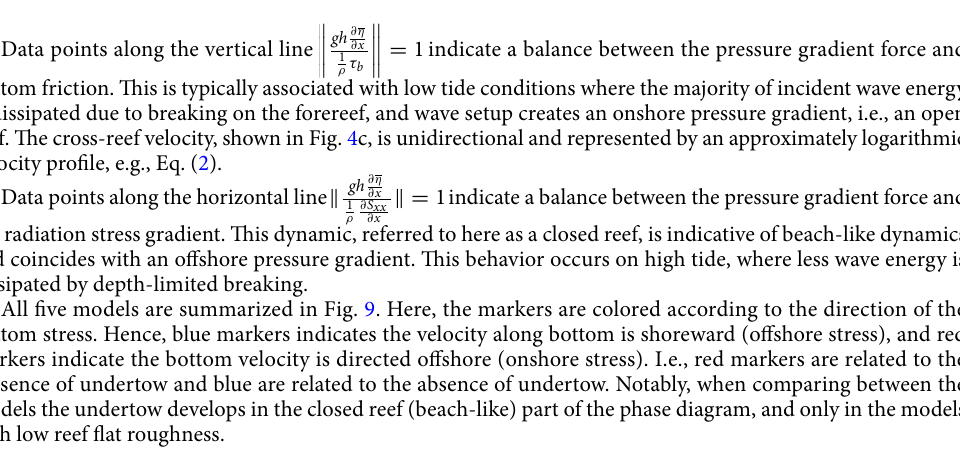
gh ∂η ∂ x = 1 indicate a balance between the pressure gradient force and 1 ρ τ b (cid:31) (cid:31) (cid:31) (cid:31) (cid:31) (cid:31) (cid:31) (cid:31)